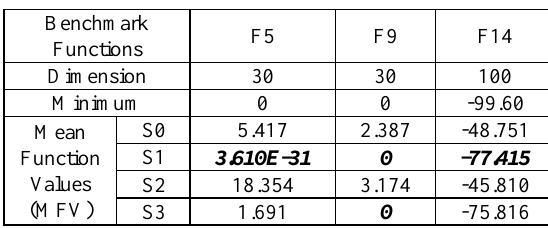
Table 1 Analysis of Four Types of Opposition-Based Operation